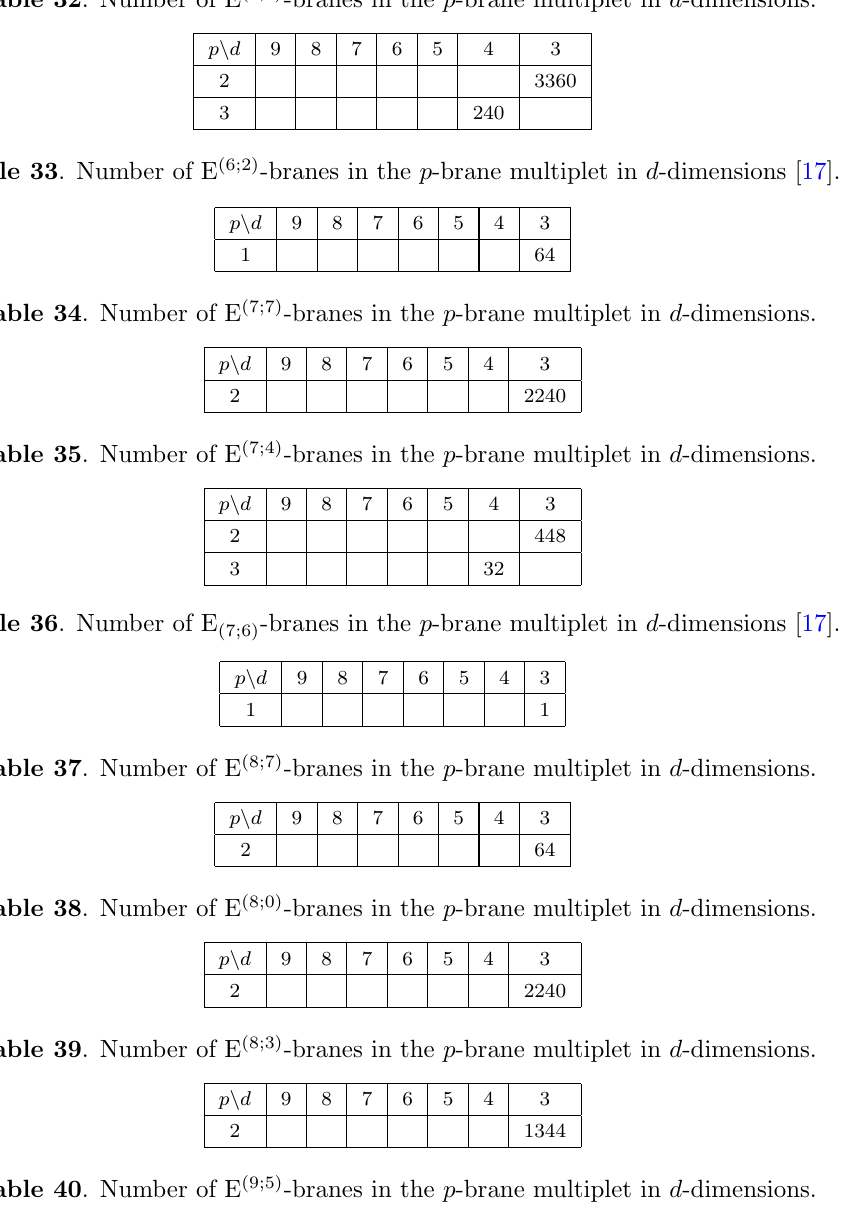
Table 32 . Number of E (6;4) -branes in the p -brane multiplet in d -dimensions.